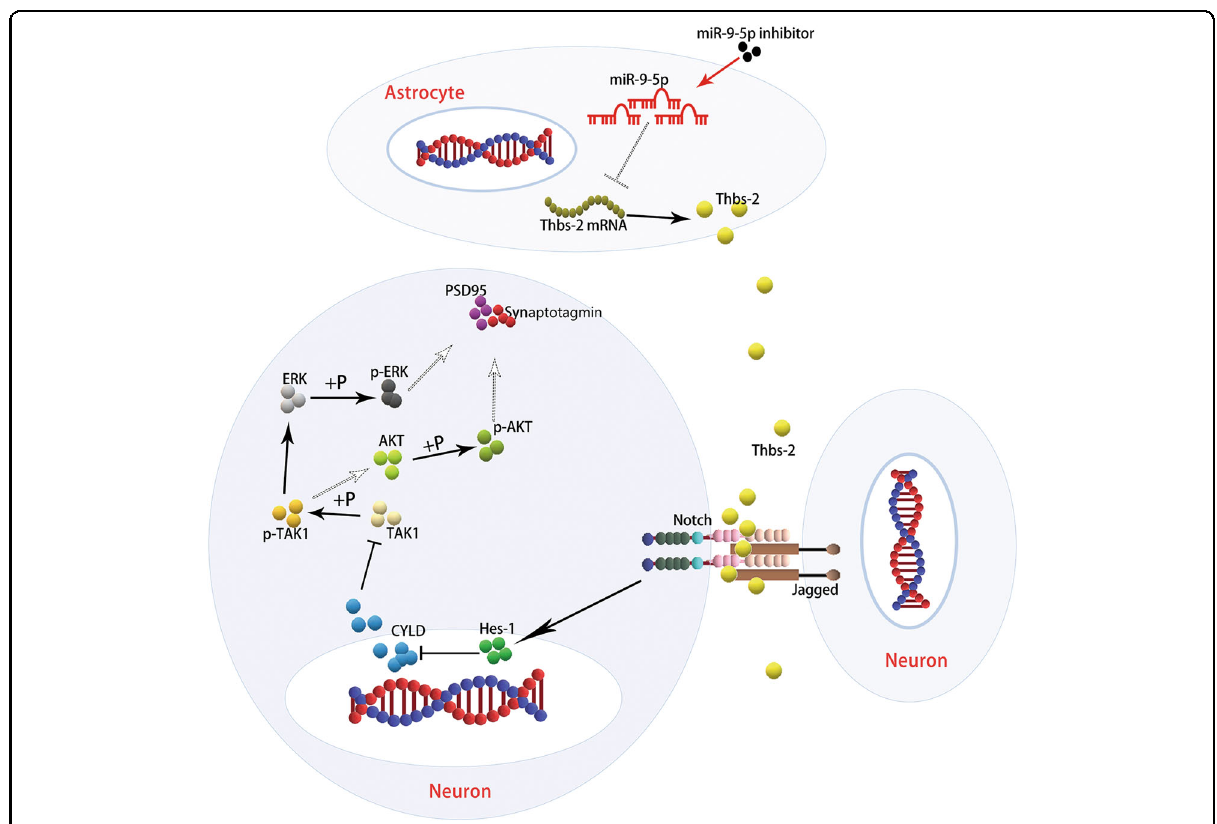
Fig. 7 Schematic summary of the miRNA-9-5p/Thbs-2/Notch pathway. The neurovascular unit (NVU) is reconstructed by brain microvascular endothelial cell, astrocyte, and neuron. Transfection of microRNA-9-5p (miRNA-9-5p) inhibitor blocks the inhibitory effect of miRNA-9-5p on thrombospondin 2 (Thbs-2), which promotes the expression of Thbs-2 protein in astrocytes and increases the concentration of Thbs-2 protein between neurons. Moreover, Thbs-2 promotes the activation of Notch pathway for neuron, which blocks the inhibitory effect of cylindromatosis (CYLD) on transforming growth factor- β -activated kinase 1 (TAK1) and promotes the phosphorylation of TAK1 (p-TAK1). The p-TAK1 promotes the phosphorylation of extracellular signal-regulated kinase (ERK) and protein kinase B (AKT), and activates the ERK and AKT pathways, which promotes the expression of neuronal synapse protein including post-synaptic density protein 95 (PSD-95) and